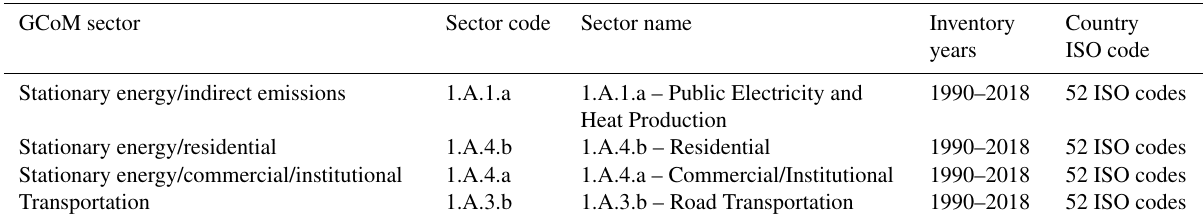
Table 4. Mapping of emission source categories with IPCC